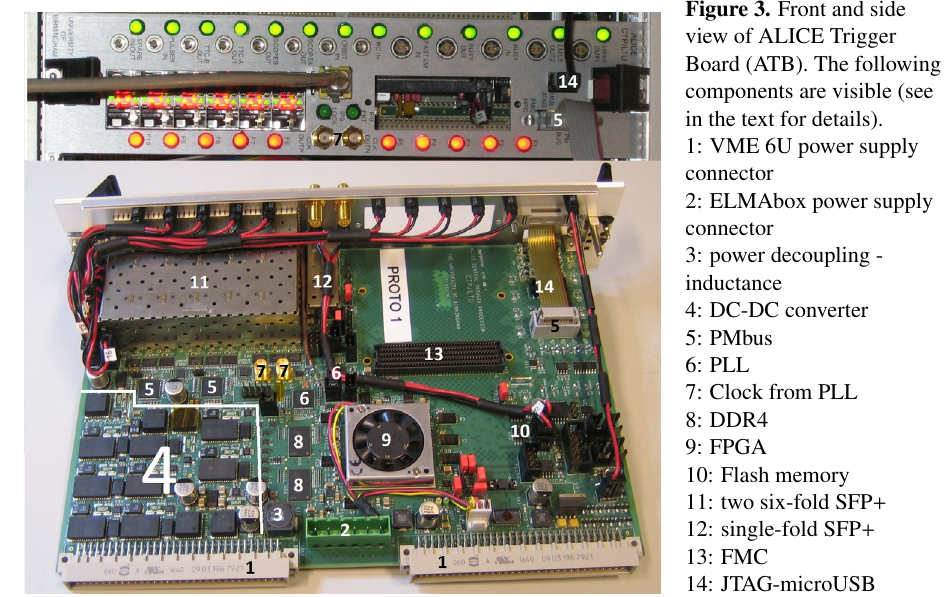
Figure 3. Front and side view of ALICE Trigger Board (ATB). The following components are visible (see in the text for details).